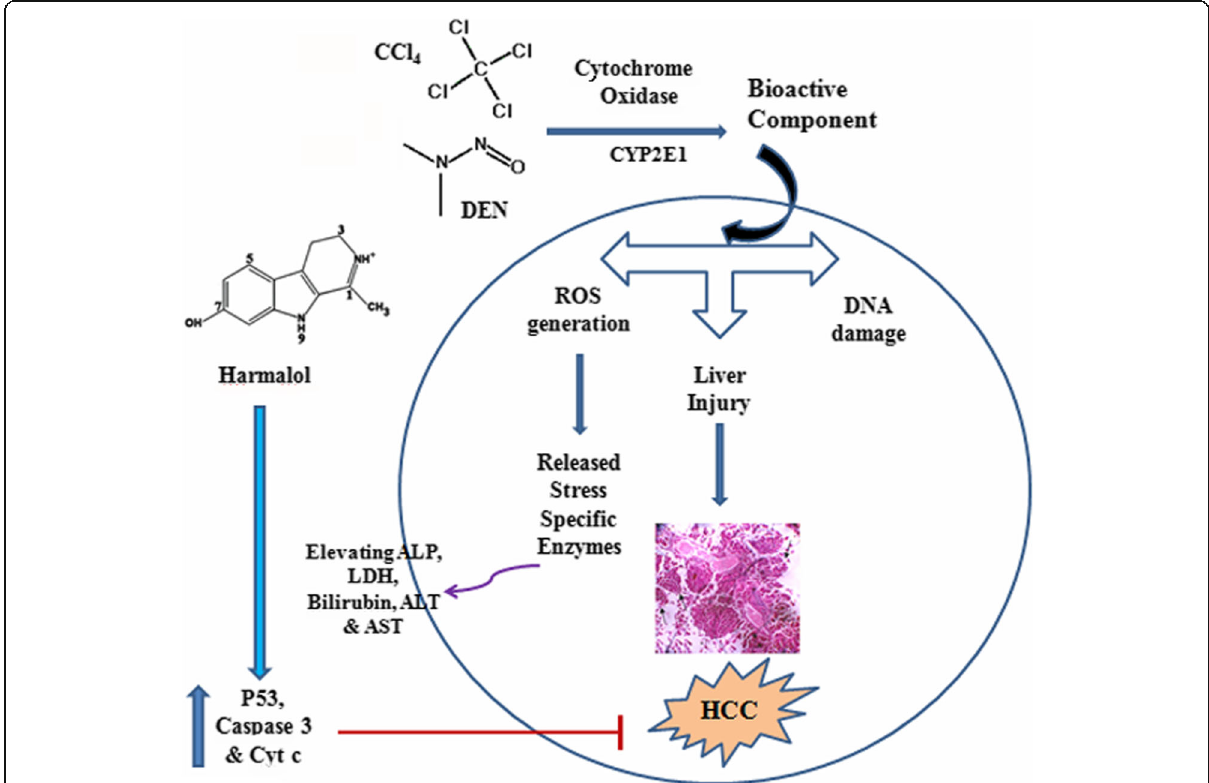
Fig. 10 Schematic representation of the cause of HCC and therapeutic potential of harmalol against